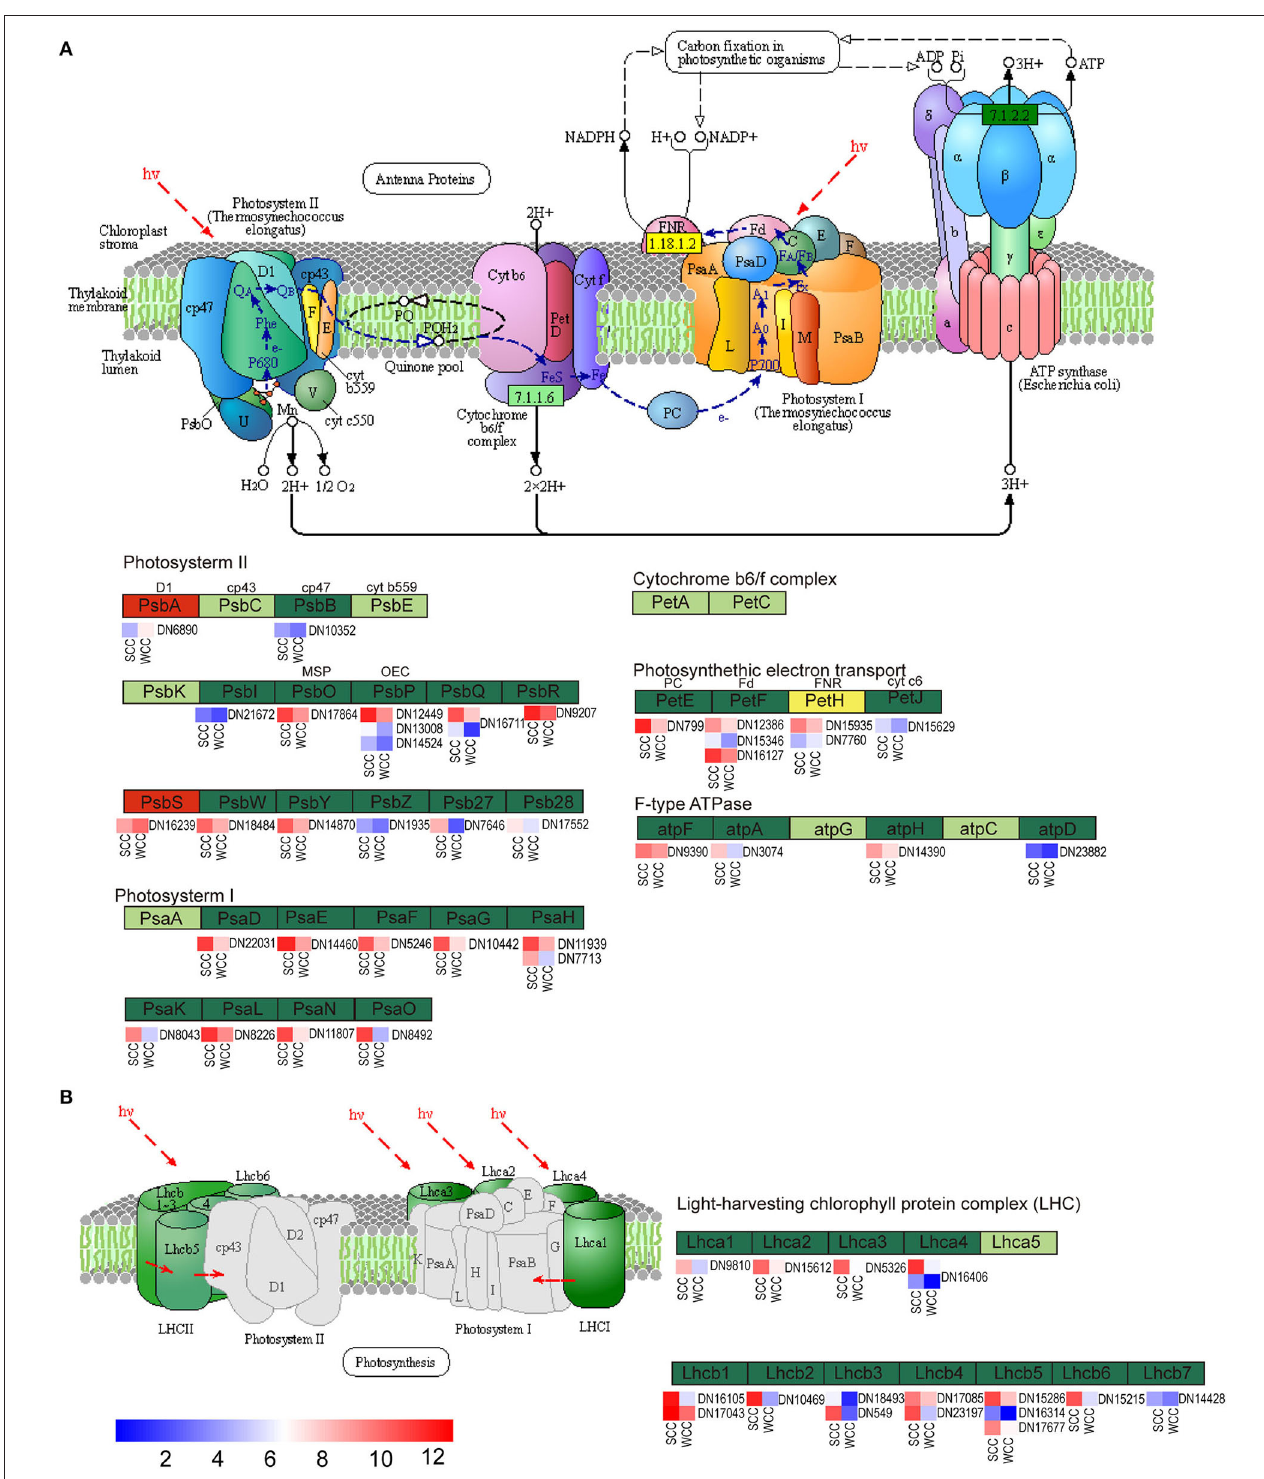
FIGURE 6 | Metabolic pathway map of photosynthesis-related biosynthesis. (A) Photosynthesis pathway; (B) photosynthesis-antenna protein pathway. Dark red/green represents up/downregulated genes, yellow represents genes that were both up- and downregulated, and small red/blue squares indicate the expressed levels of unigenes. SCC and WCC, summer and winter Chinese cedar needle samples, respectively. The abbreviations of each gene are as follows: F-type ATPase ( atpF , A , H , and D ); light-harvesting chlorophyll protein complex ( Lhca1–4 and Lhcb1–7 ); photosynthetic electron transport ( PetE , F , H , and J ); photosystem I ( PsaD , E , F , G , H , K , L , N , and O ); and photosystem II ( PsbA , B , I , O , P , Q , R , W , Y , Z , 27 , and 28 ).